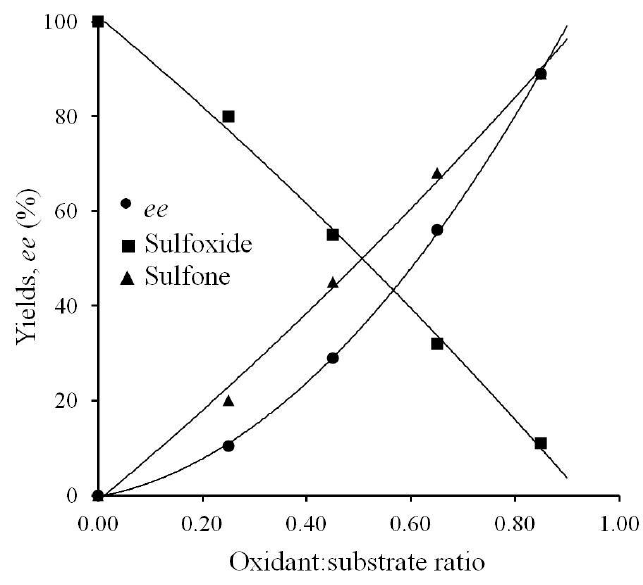
Figure 1. Kinetic resolution of racemic PhMeSO with catalyst [MoO(O 2 ) 2 (H 2 O) n ]/ 1c /[PPh 4 ]Br (CHCl 3 , 0 °C, sulfoxide:Mo ratio of 100:2.5): sulfoxide and sulfone yields and the ee of the ( R )-sulfoxide versus the oxidant:substrate ratio.